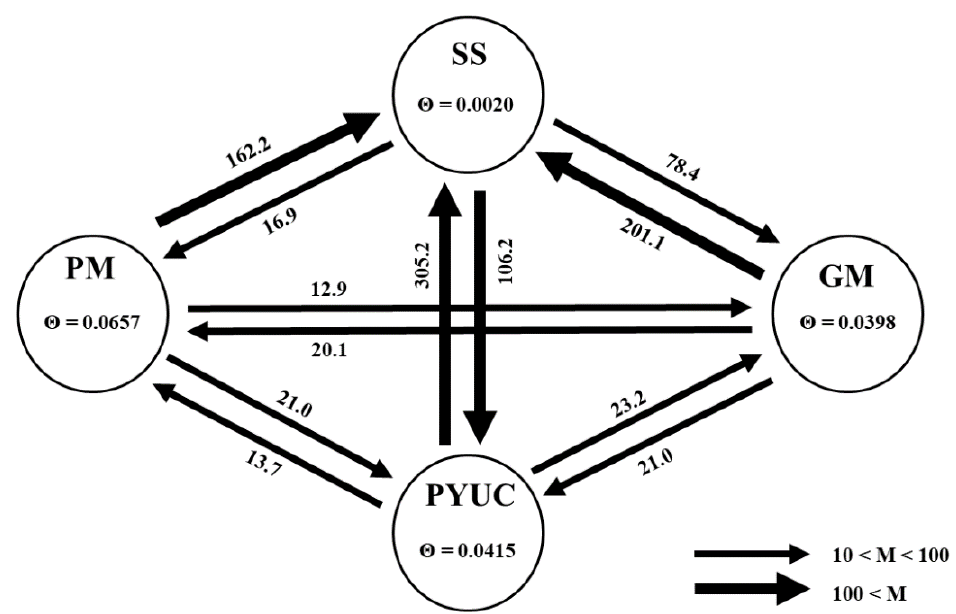
Figure 4. Estimates of gene flow between haplogroups (PM—Mexican Pacific; GM—Gulf of Mexico; PYUC—Yucatan Peninsula; SS—San Sebastian). Values within circles are the mutation-scaled effective population size ( θ ) with 95% confidence intervals. Arrows indicate the direction of gene flow between haplogroups. Values on the line represent the relative mutation-scaled migration rates (M) calculated from MIGRATE.